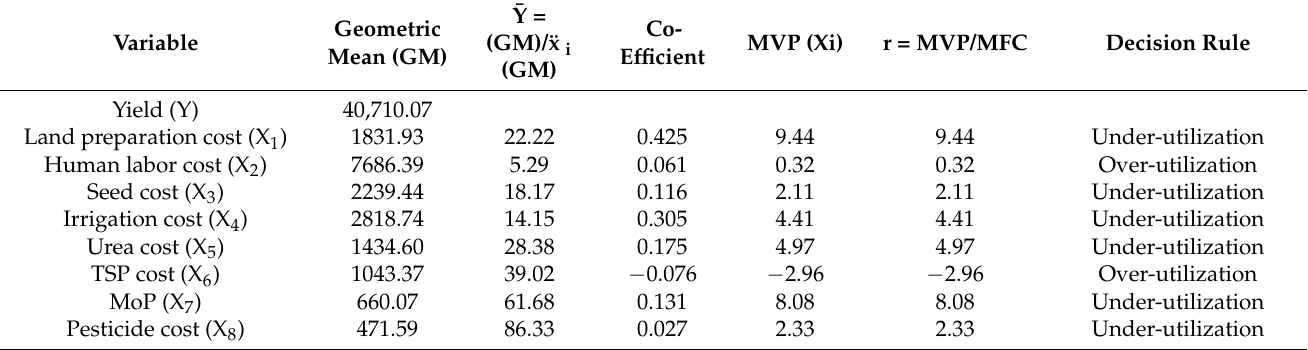
Table 6. Estimated input use efficiency in maize